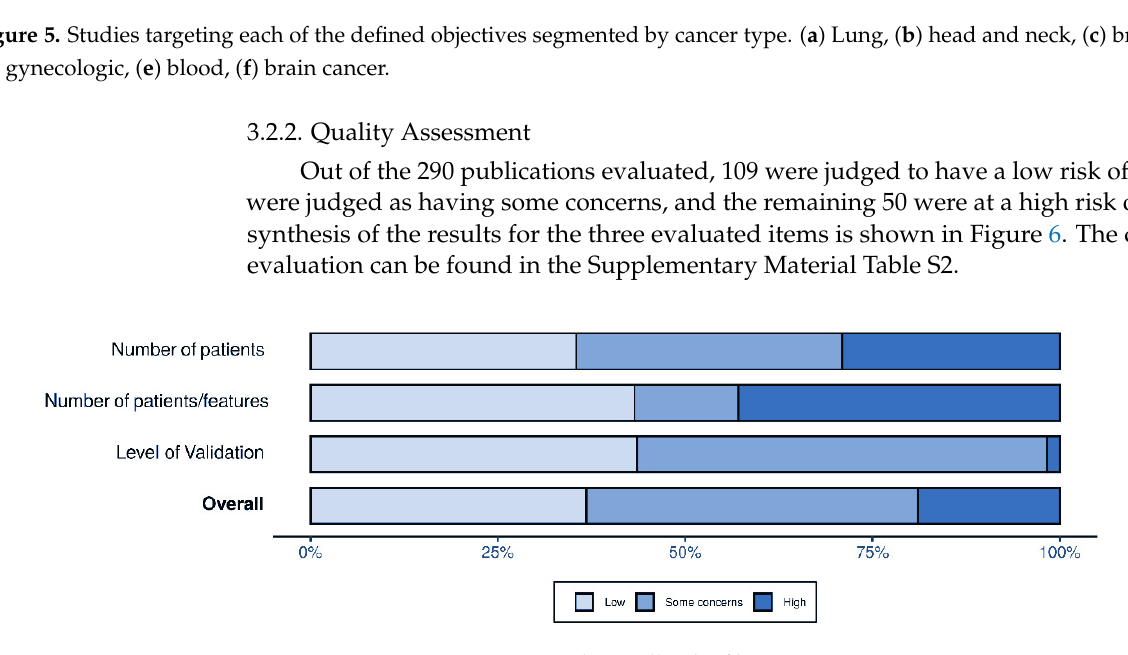
Figure 5. Studies targeting each of the defined objectives segmented by cancer type. ( a ) Lung, ( b ) head and neck, ( c ) breast, ( d ) gynecologic, ( e ) blood, ( f ) brain cancer.